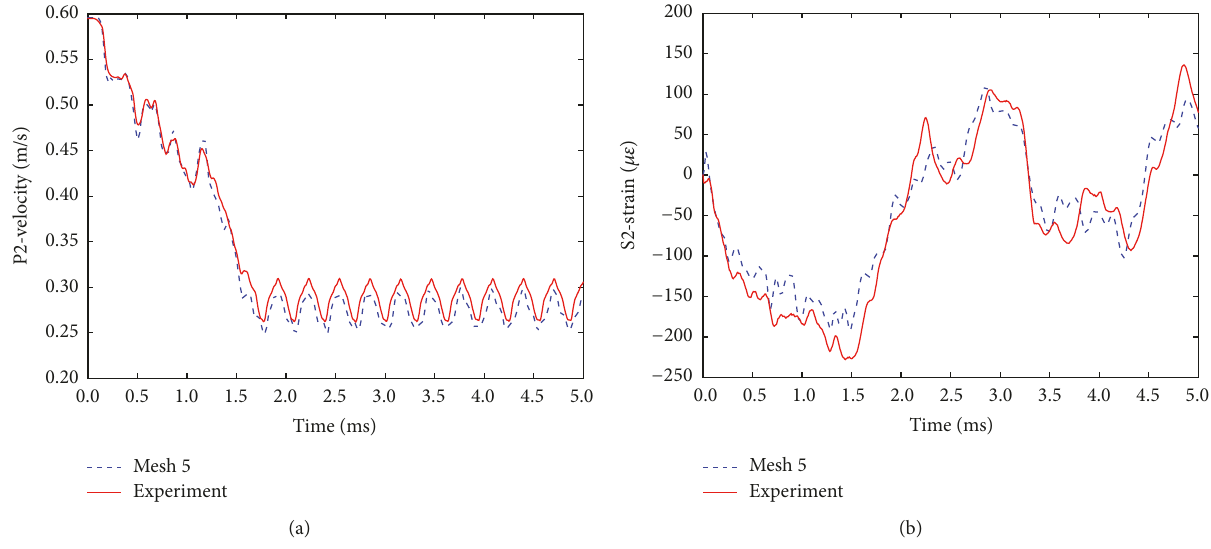
Figure 9: Comparisons between convergent simulation and experiment: (a) velocity of point P2; (b) strain of point S2.